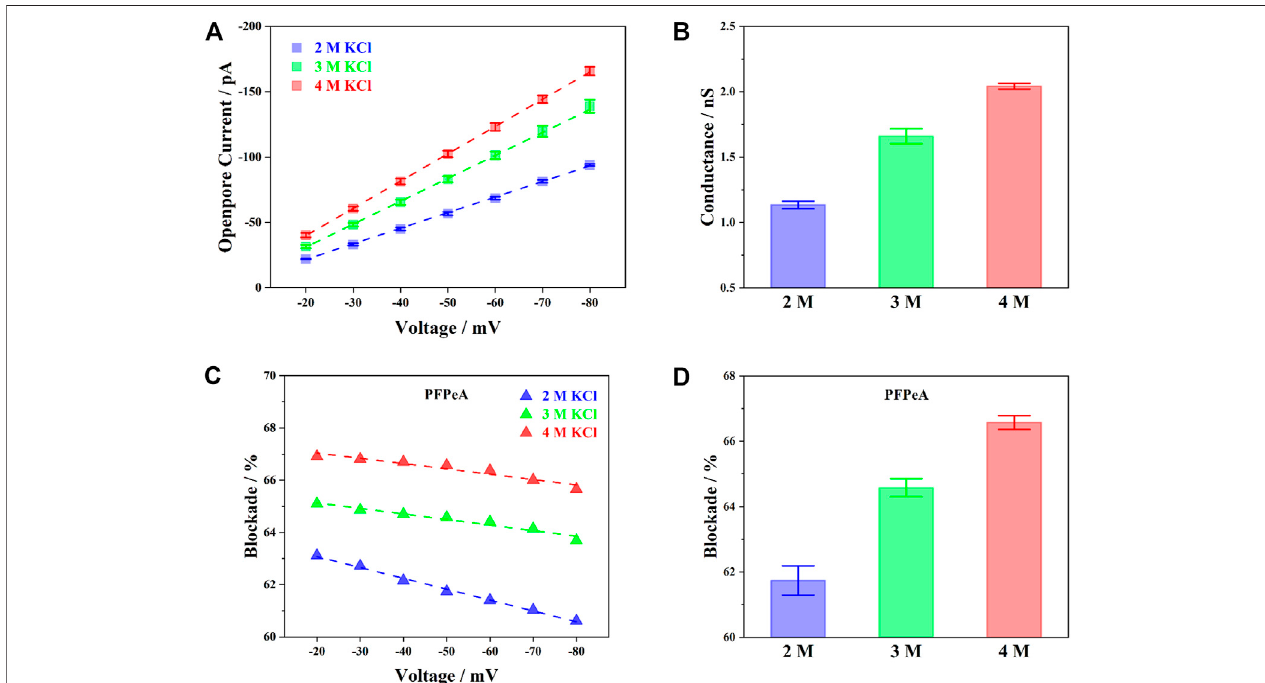
FIGURE 2 | In fl uence of electrolyte concentration on (A) voltage-dependent open-pore current, (B) pore conductance at − 50 mV, (C) voltage-dependent current blockade of PFPeA, and (D) the current blockade ay − 50 mV.